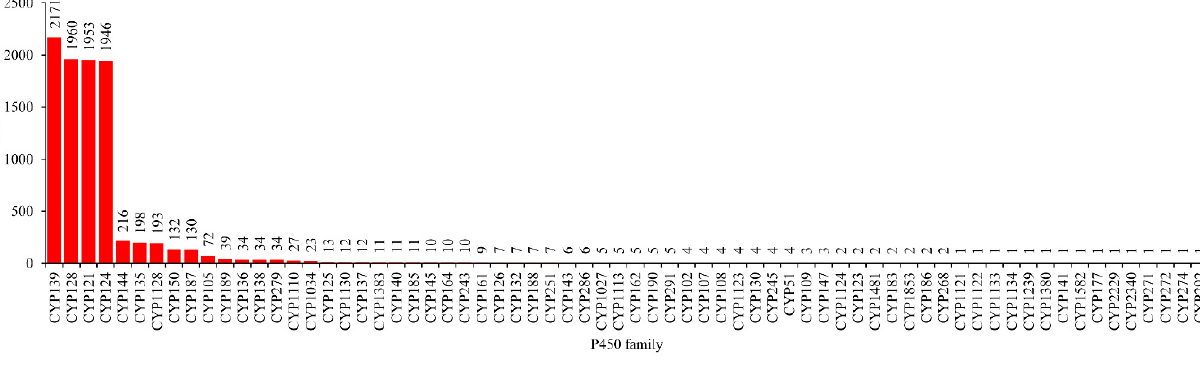
Figure 3. Comparative analysis of P450s involved in natural metabolite biosynthesis in mycobacterial species. The number next to the bars represents the number of members in a P450 family. Detailed information on the P450s part of biosynthetic gene clusters (BGCs), their species names, and BGC types are presented in Table S6. An analysis of the member P450s part BGCs as per their mycobacterial categories is presented in Table S7.